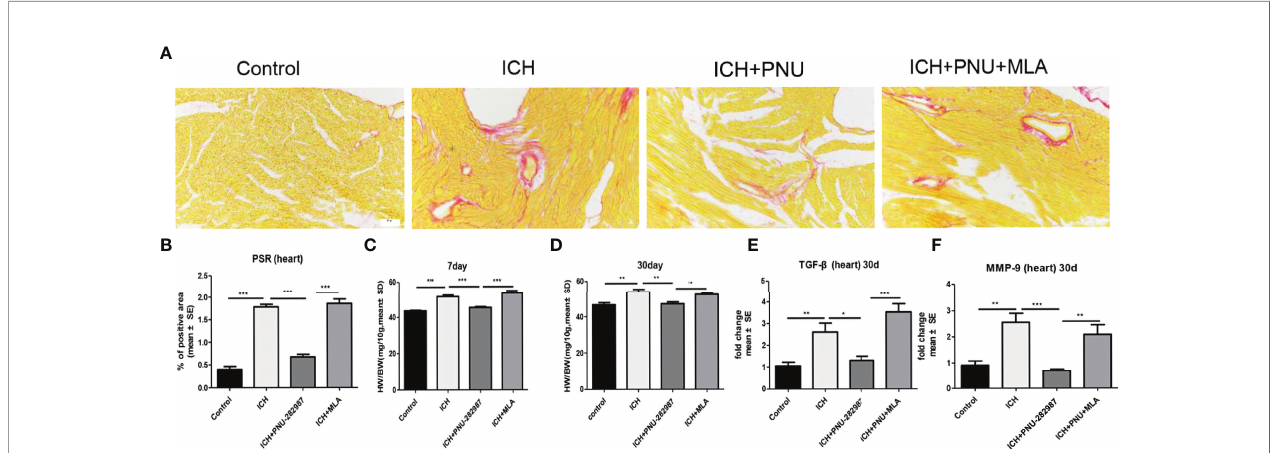
FIGURE 3 | Activating a 7nAChR signi fi cantly decreased cardiac fi brosis and cardiac hypertrophy in the chronic phase of intracerebral hemorrhage. (A) Representative results for PSR immunostaining in heart tissue at 30 days. (B) Quanti fi cation of interstitial fi brosis (Picro Sirius Red). n = 6 per group. (C) The result of heart weight at 7 days. (D) The result of heart weight at 30 days. (E) The PCR results showed that treatment with PNU-282987 signi fi cantly reduced the gene expression of the ICH- caused pro fi brotic factor TGF- b compared with ICH mice at 30 days. (F) PNU-282987 signi fi cantly reduced the gene expression of the ICH-caused pro fi brotic factor MMP-9 compared with ICH mice at 30 days. n = 6 per group. Data are presented as mean ± SE; *p < 0.05; **P < 0.01; ***P <